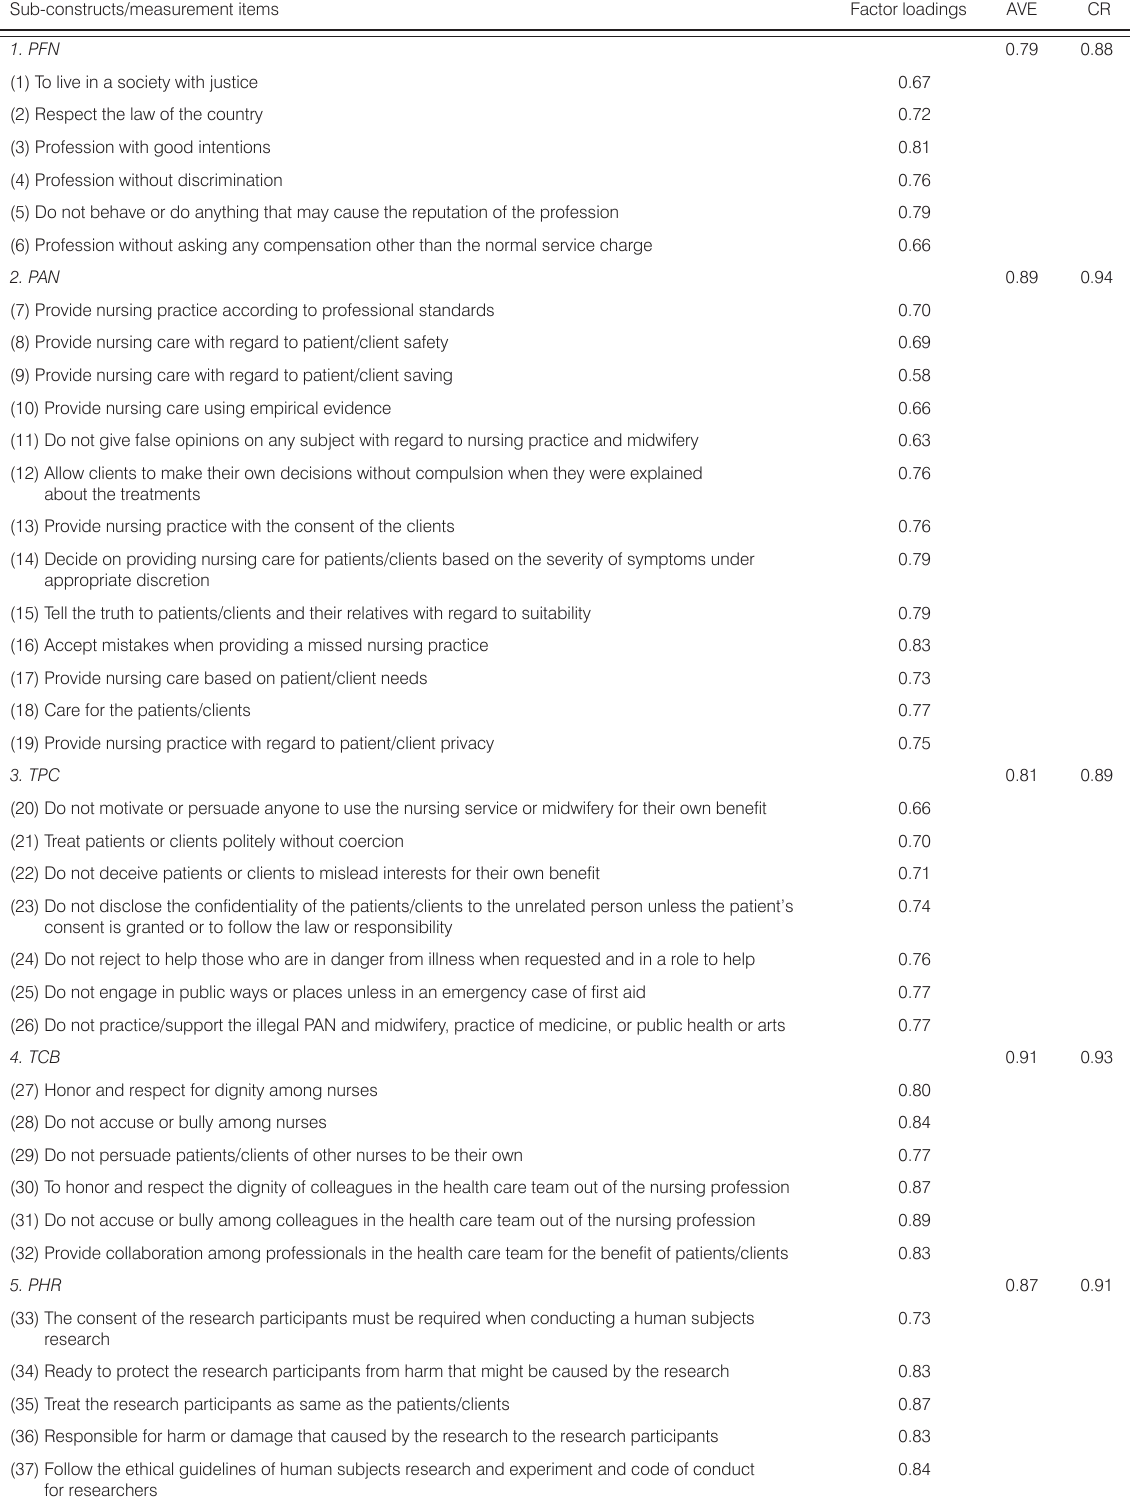
Table 4. Factor loadings of measurement items for each sub-construct, AVE, and the CR of 5